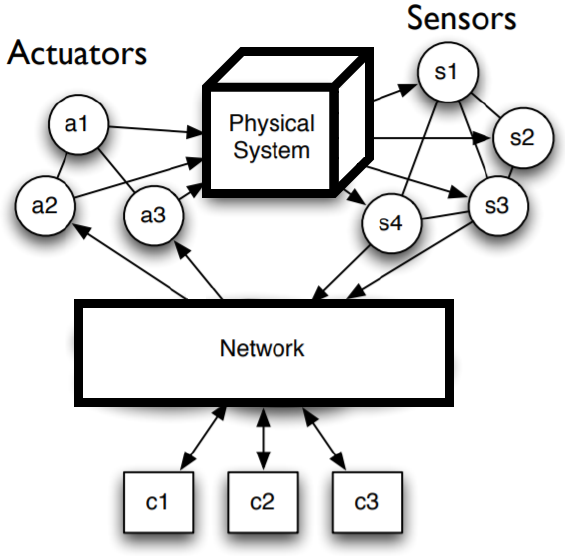
Figure 5. The architecture of Control System with CPS.